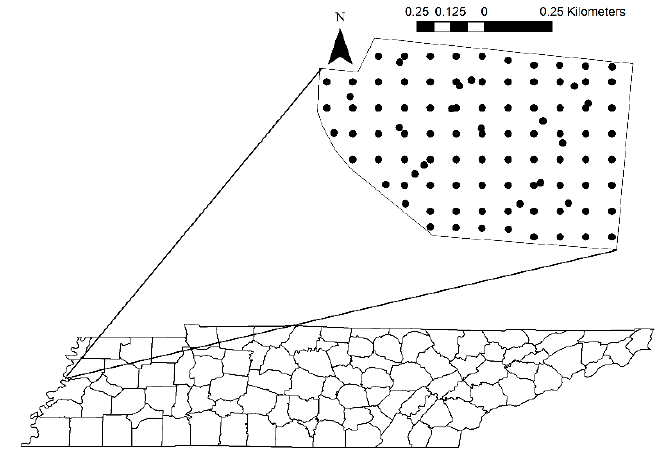
Figure 1. The 73-ha supplemental irrigation study field is located in southwestern Dyer County in west Tennessee along the Mississippi river. Soil samples were collected at four depths from 0–1 meter at 100 locations.